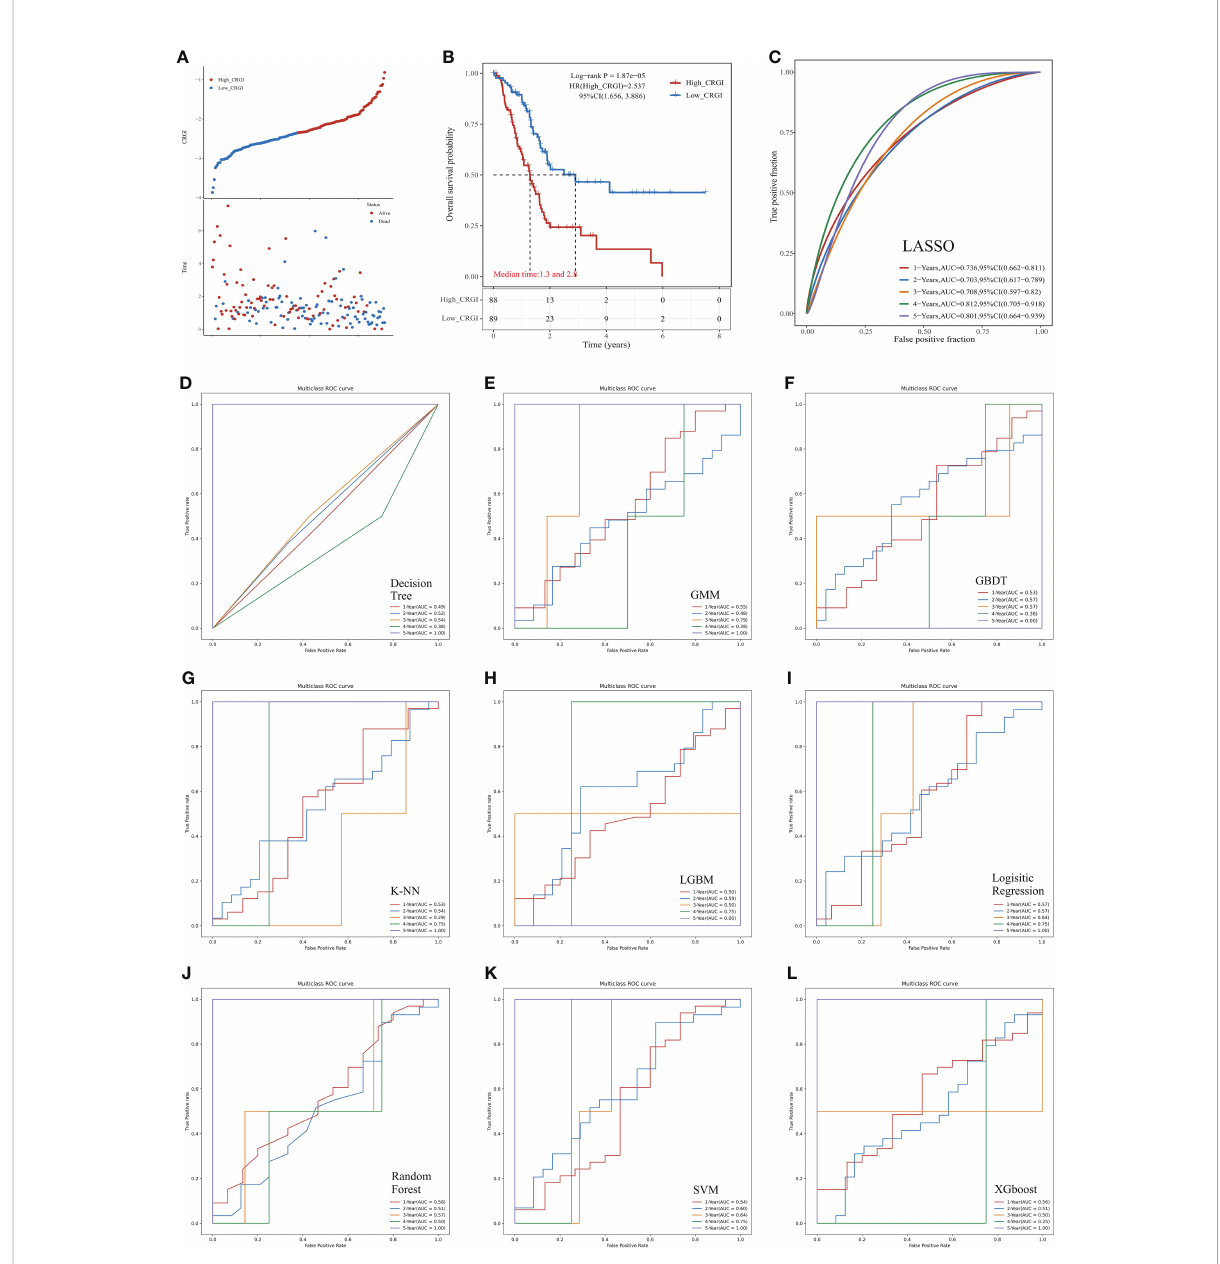
FIGURE 2 Predictive performance comparison of the 10 mainstream machine learning algorithms in the TCGA dataset. (A) Distribution of the CRGI and survival status of individual PAAD patients. (B) Survival analysis of the high- and low-CRGI groups. (C) The time-dependent ROC curve with the AUC value of 1-, 2-, 3-, 4-, and 5-year OS prediction of the best model optimized by LASSO penalized Cox regression. (D – L) The predictive accuracy of other machine learning algorithms (i.e., Decision Tree, GMM, GBDT, K-NN, LGBM, Logistic Regression, Random Forest, SVM, and XGboost,